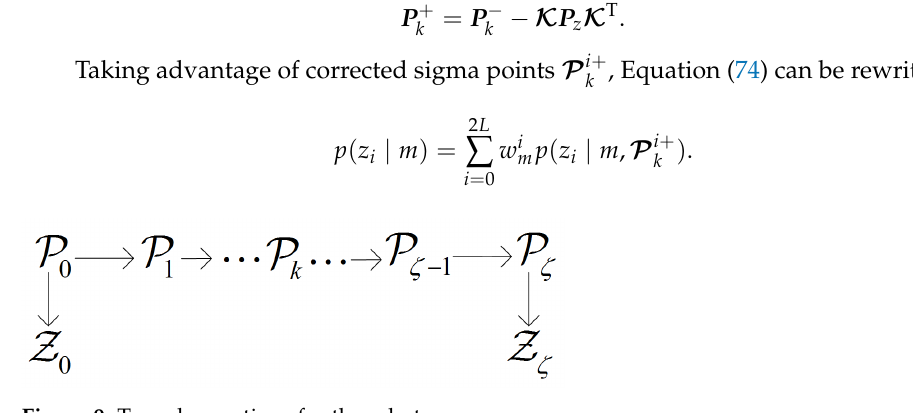
Figure 9. Two observations for the